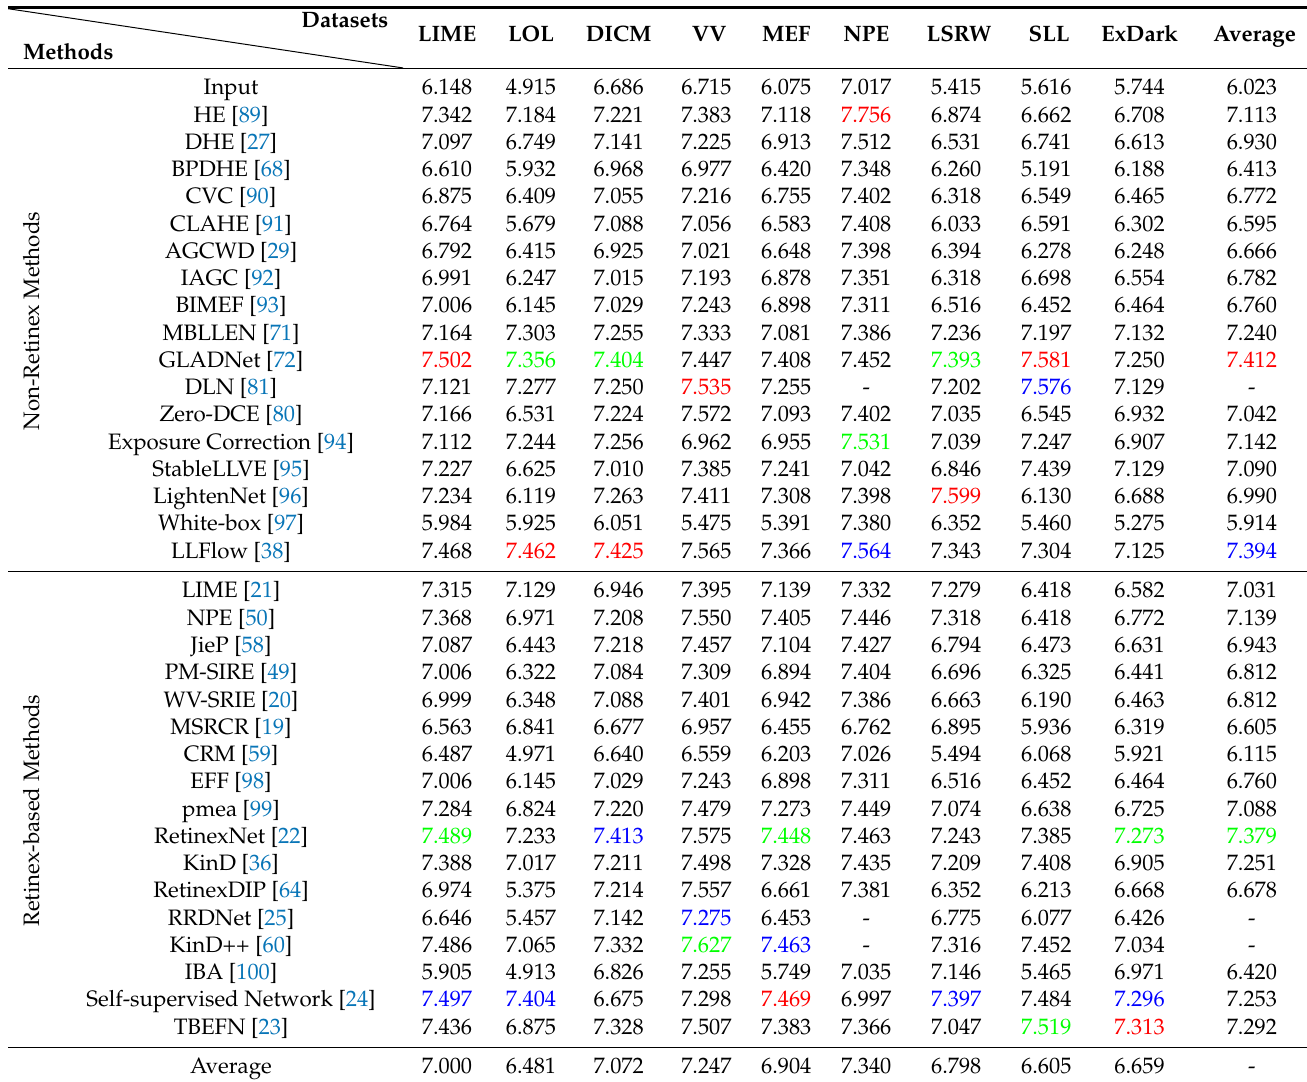
Table 3. Quantitative comparison of enhancement algorithms on nine test datasets using entropy [86] metric. A higher value of the entropy metric indicates better performance. The first, second, and third best scores are highlighted with red, blue, and green colors,